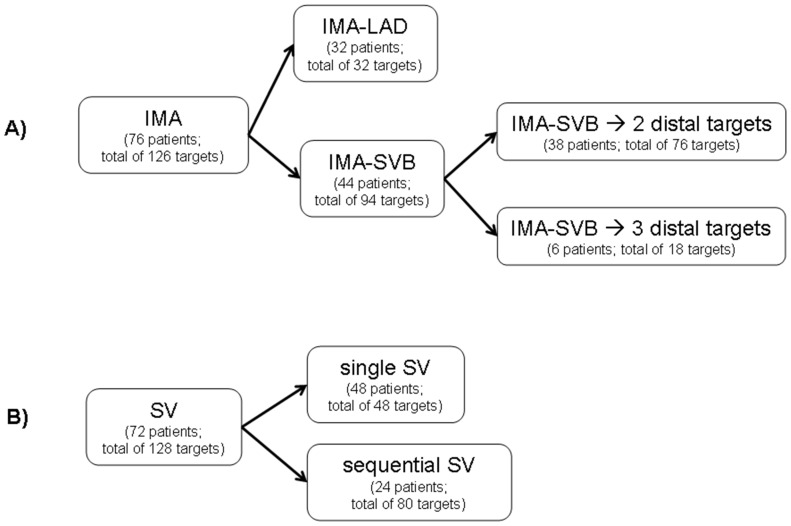
Coronary artery bypass grafts in the 78 patients of the study.Distribution of A) internal mammary artery (IMA) grafts and B) saphenous vein (SV) grafts in 78 patients with a total of 254 coronary artery bypass grafts (CABG) scanned with 256-slice MDCT. IMA-LAD indicates simple IMA grafts to the left anterior descending artery, and IMA-SVB, composite IMA with saphenous vein bridge grafts. An IMA-SVB graft redistributes the flow of the IMA to two or more coronary arteries (distal targets) of the anterolateral territory, usually to the left anterior descending artery as well as to one or more diagonal arteries, or to the ramus intermedius artery. A single SV graft has a proximal anastomosis on the ascending aorta, and a distal terminolateral anastomosis on one distal target. A sequential SV graft has a proximal anastomosis on the ascending aorta, and sequential distal anastomoses on two (or more) distal targets: one (or more) laterolateral anastomosis, and a most distal one which is terminolateral. Most patients had both an IMA graft (used as a simple or composite graft) and one (or more) SV graft(s).